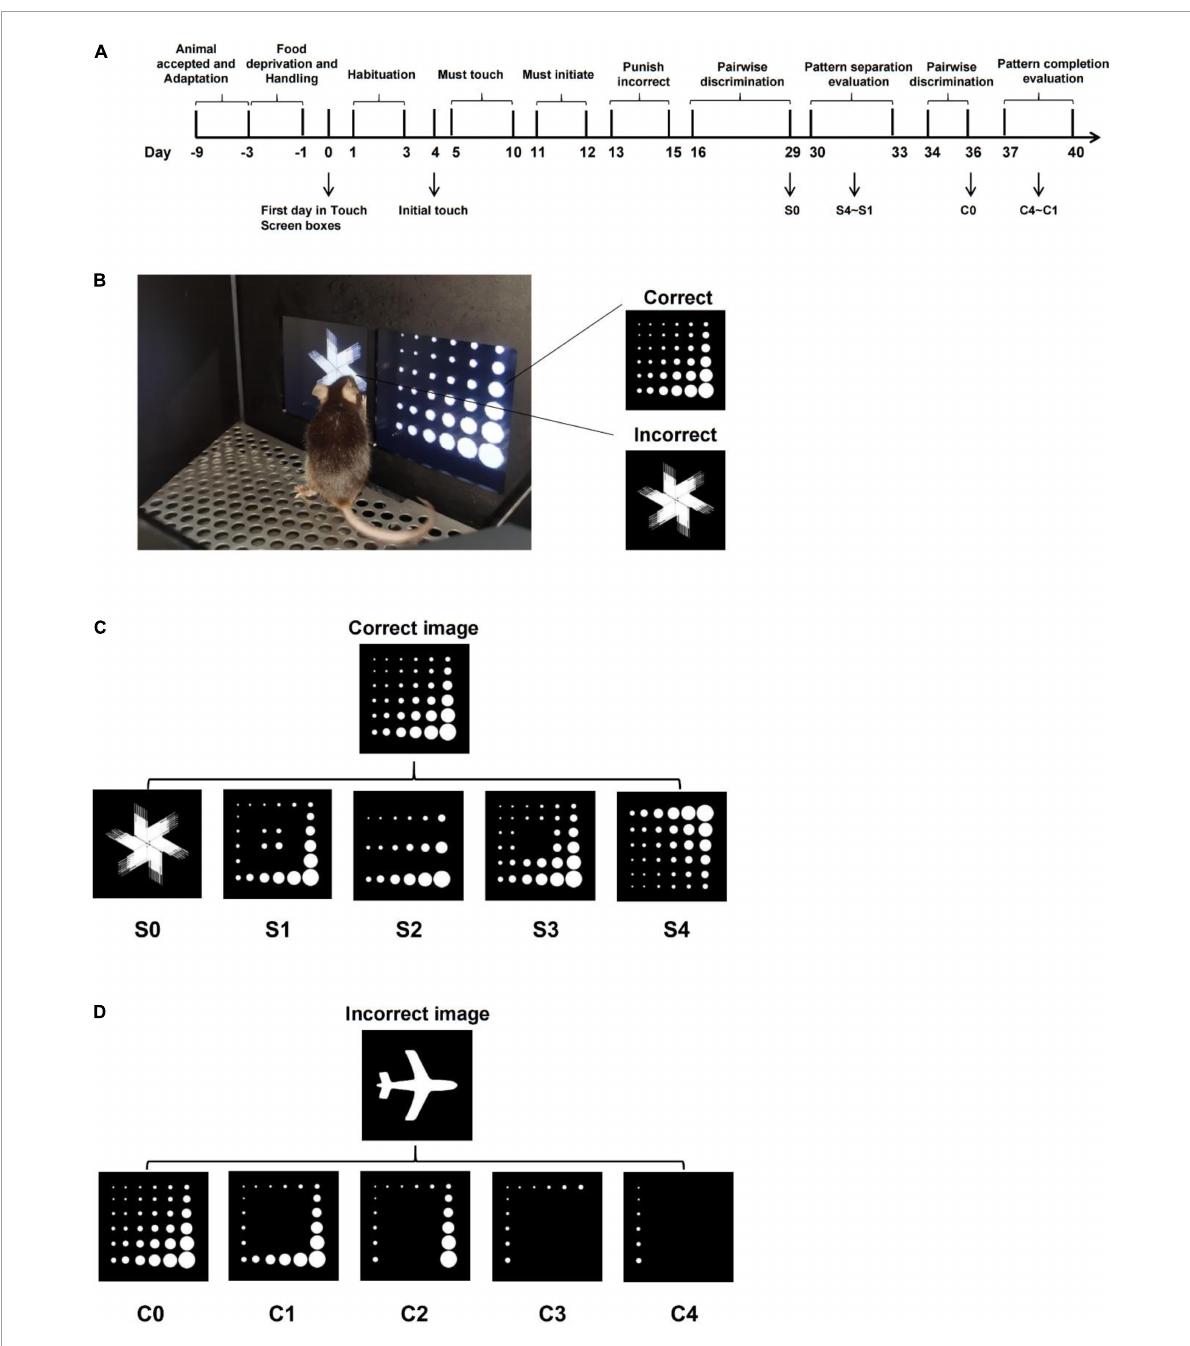
FIGURE1 Schematic representation of adapted paradigms for pattern separation and pattern completion based on pairwise discrimination task. (A) Training flowchart of the pairwise discrimination task. (B) Schematic representation of touchscreen (correct image “Marble” is on the right side of the screen; incorrect image “Fan” is on the left side of the screen). (C) Schematic representation of pattern separation paradigm of varying difficulty (“S” means separation; the number behind S represents the difficulty index, the higher the number, the more difficult it is). (D) Schematic representation of pattern completion paradigm of varying difficulty (“C” means completion; the number behind C represents the difficulty index; the higher the number, the more difficult it is).